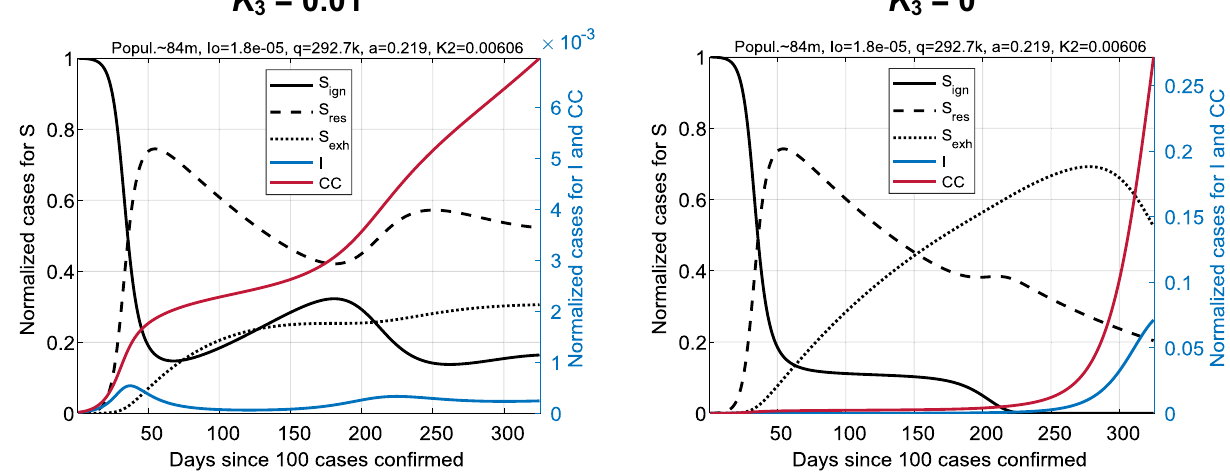
Figure 7. Comparison of coronavirus outbreaks at K 3 = 0.01 (left panel) and K 3 = 0 (right panel): a case for Germany. The proportion of infected, I, and the number of cases, CC, on the right panel became orders of magnitude higher over time than on the left. Note that the scale for I and CC on the right differs from the left by a factor of 40 (approximately). The second wave on the right will involve almost the entire